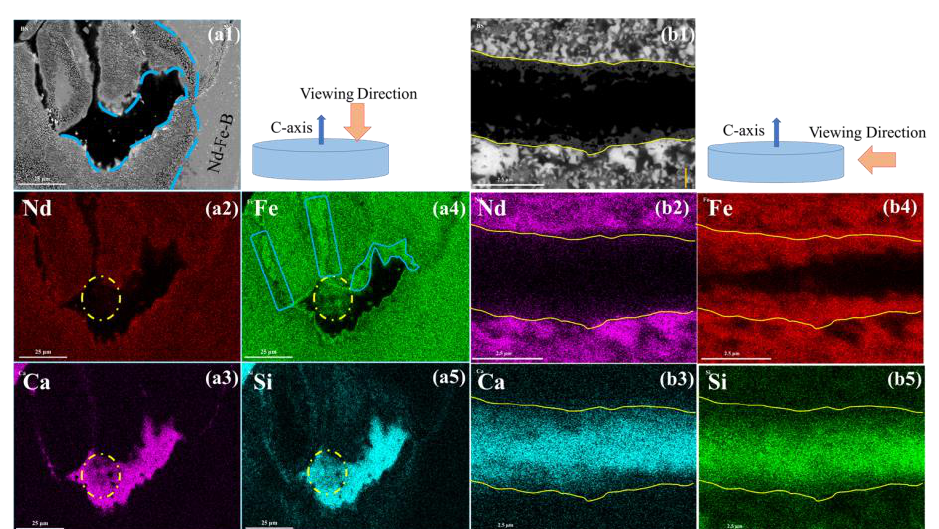
Figure 3. EDS mapping in a different direction of hot-deformed magnet with 10%wt glass fiber. ( a1 – a5 ) parallel to the pressure direction and ( b1 – b5 ) are perpendicular to the pressure direction.